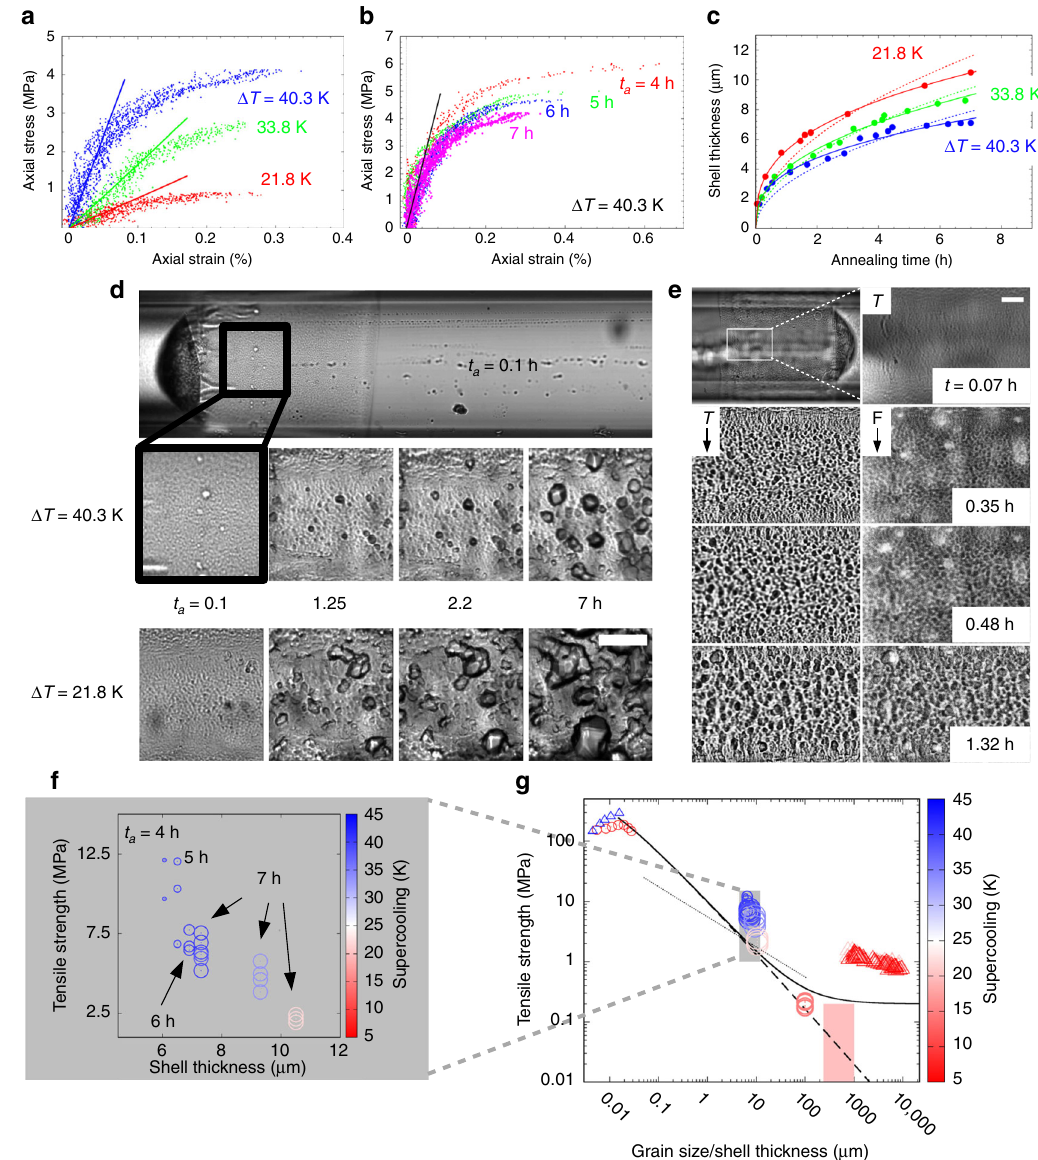
Fig. 3 Grain-size controls the tensile properties of methane hydrate. a , b Stress – strain data under monotonic loading to failure, for several points in typical samples. Straight lines in a are axial elastic constants E = 0.8, 1.6 and 4.9 GPa at supercoolings Δ T = 21.8, 33.8 and 40.3 K; c Thickening of the shell at different supercoolings Δ T . Solid lines: w ( t ) ∝ t γ with γ = 0.35, 0.4 and 0.35 at Δ T = 21.8, 33.8 and 40.3 K. Dashed lines: fi ts to γ = 1/2; d Grain size evolves with both annealing time t a and supercooling, Δ T . Scale bar: 50 μ m; e The rigidochrome fl uorescent dye DASPI marks grain boundaries in a maturing halo ( Δ T = 40.3 K): left transmission images (T), right fl uorescence (F). Scale bar 20 μ m; f Dependence of the von Mises tensile strength on shell thickness, as determined by the supercooling (colour coded pink through ice- to deep blue Δ T = 21.8, 38.3, 33.8 and 40.3 K, and by the annealing time, t a (symbol size); g Situation of the present data (grey box) in a log-log plot of tensile strength vs. grain-size, g , (or shell thickness at failure), with respect to experimental (large symbols) and simulated data (small symbols) on methane hydrate (circles refs. 21,24 ) and ice (triangles, refs. 25,34 ). Supercooling of all data colour coded as in part f . Dotted line: slope β = − 1/2 for a standard Hall-Petch relation, Eq. (8); Solid line: size-effect Eq. (9) with σ ∞ = 0.2 MPa, Y = 11 GPa 64 and K = 0.13; dashed line: predicted extension of the size effect into the range of grain sizes observed in marine sediments (pink box, refs. 33,76